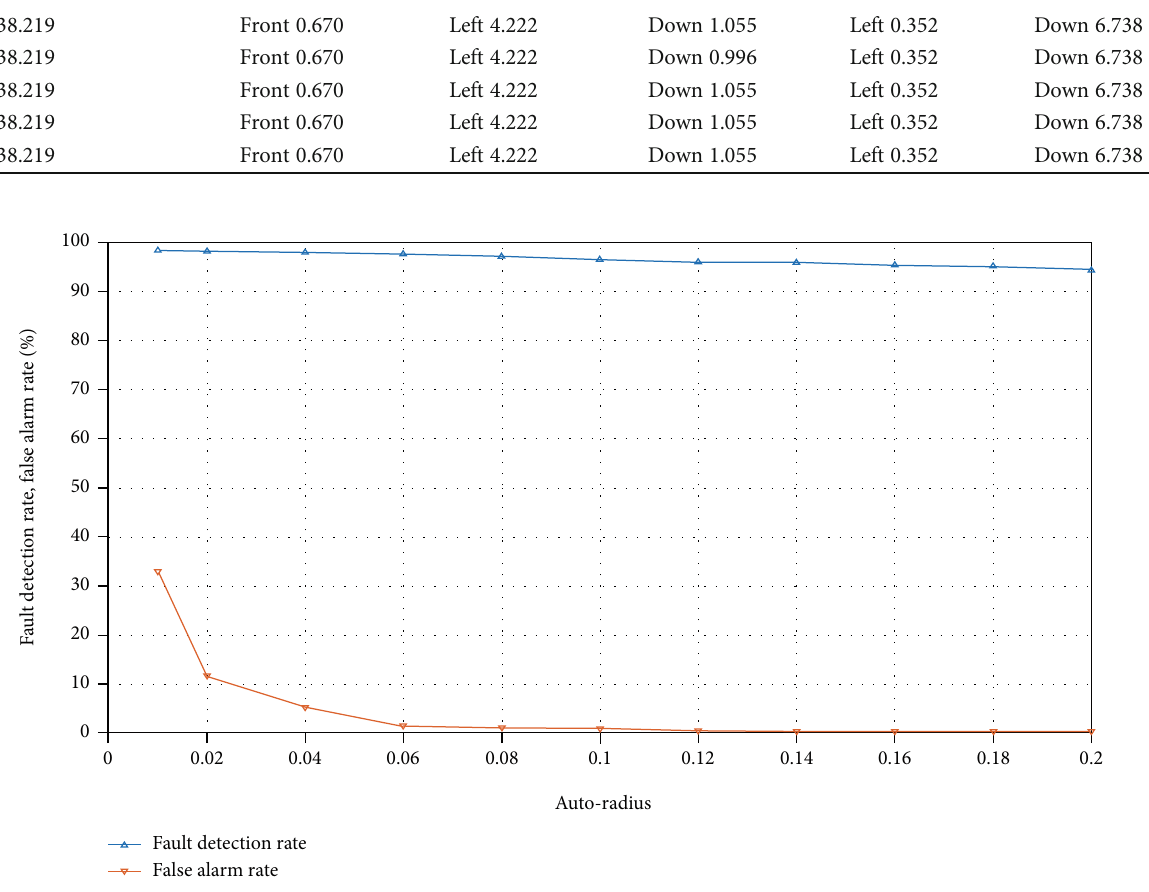
Figure 4: E ff ect of self-space auto-radius on fault detection rate and false alarm